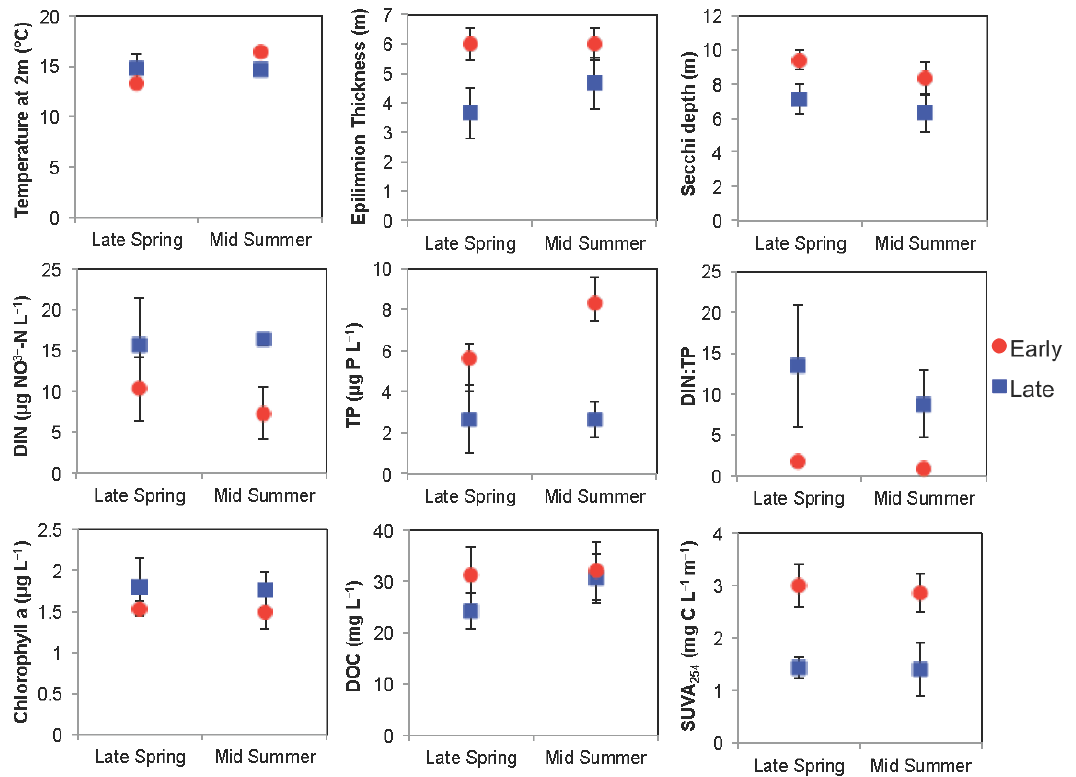
Figure 4. Comparison of lake metrics for early and late ice-out conditions during the spring and summer in Arctic lakes. Responses of the three Arctic lakes are averaged (mean ± standard error) on each date. For the 2016 early ice-out year, spring sampling occurred from 28–30 June and summer